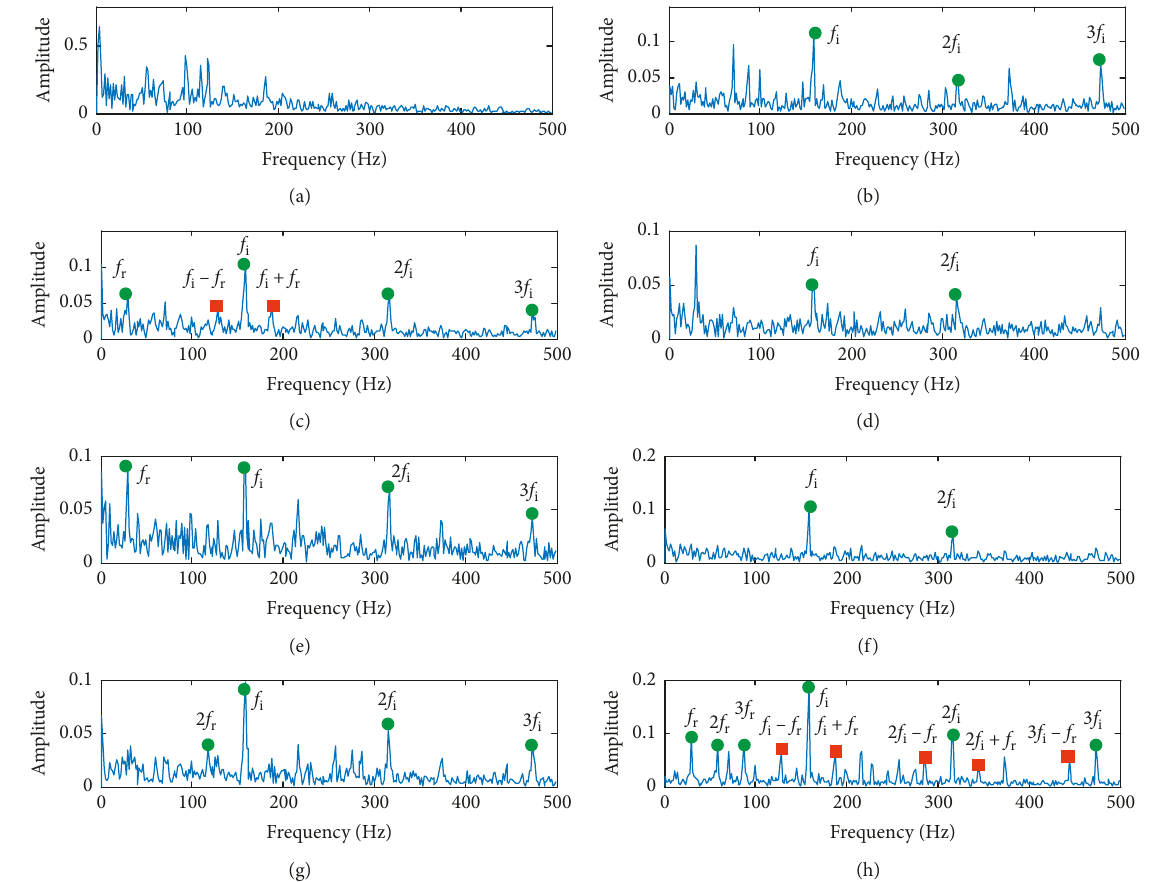
Figure 11: The frequency domain diagram of multiresolution DMD modes of the inner race fault signal, where (a)–(h) are corresponding to signals in Figure 7,